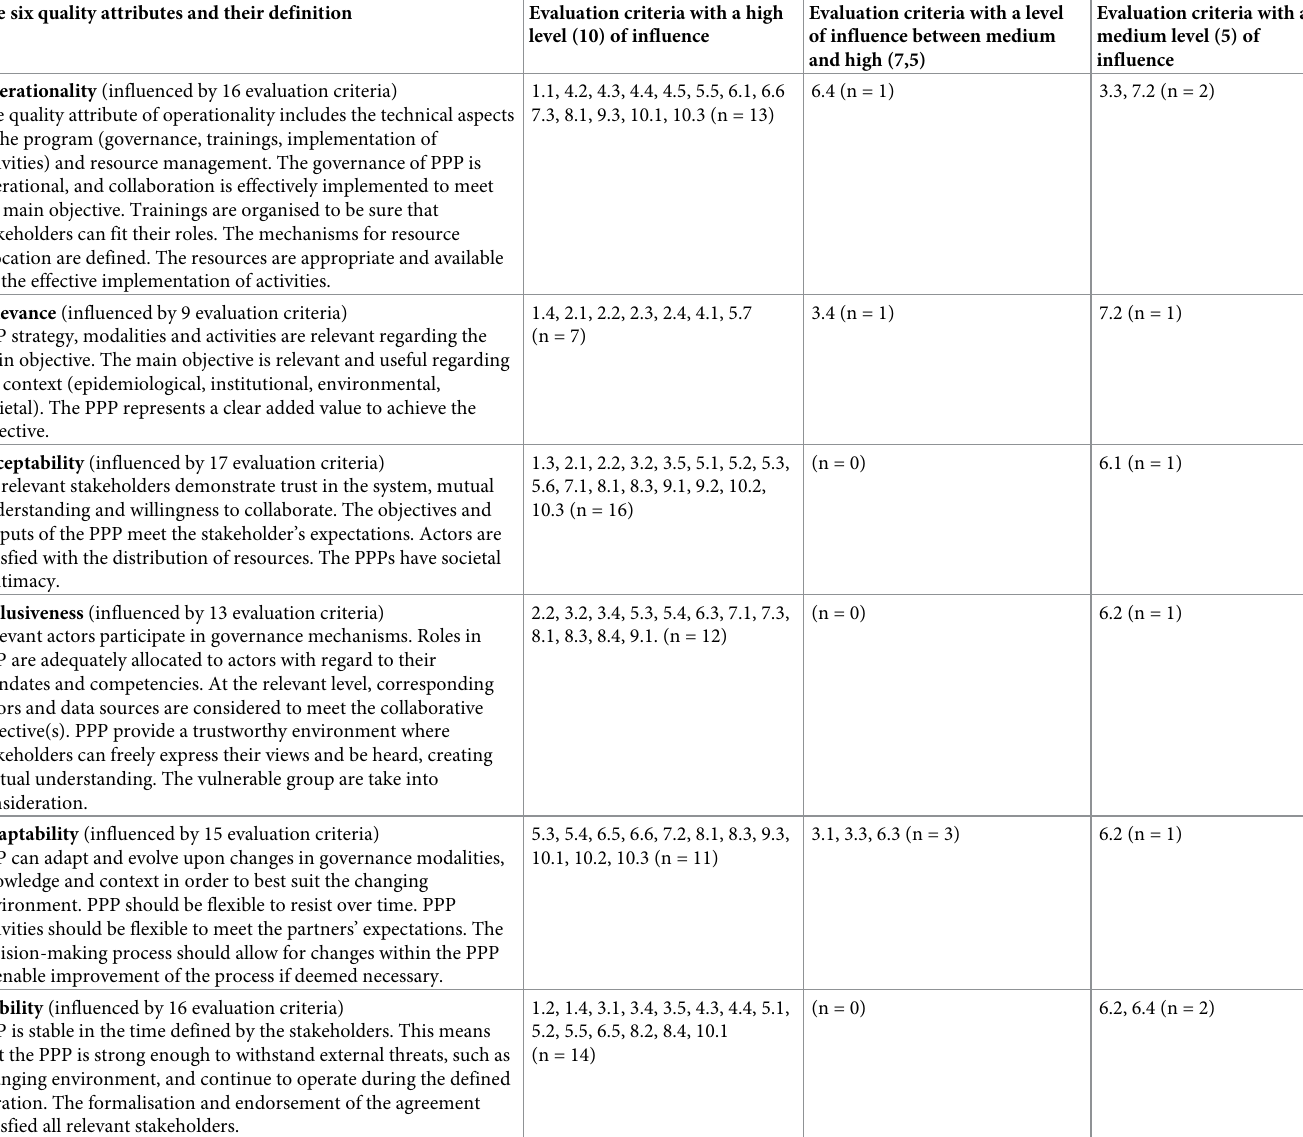
Table 3. The six quality attributes of the public-private partnership process and their definition. Those six quality attributes assess the influence of the public-private partnership process on its performance, and are influenced by different evaluation criteria. The high (score of 10) and medium (score of 5) level of influence of the evalua- tion criteria on the six attributes were validated during the experts’ elicitation as the agreement between experts reached more than 50% of the weighted percentage of experts (see Table 1). The levels of influence that did not reach 50% of the weighted percentage of experts consensus were between medium and high level and a score of 7,5 was